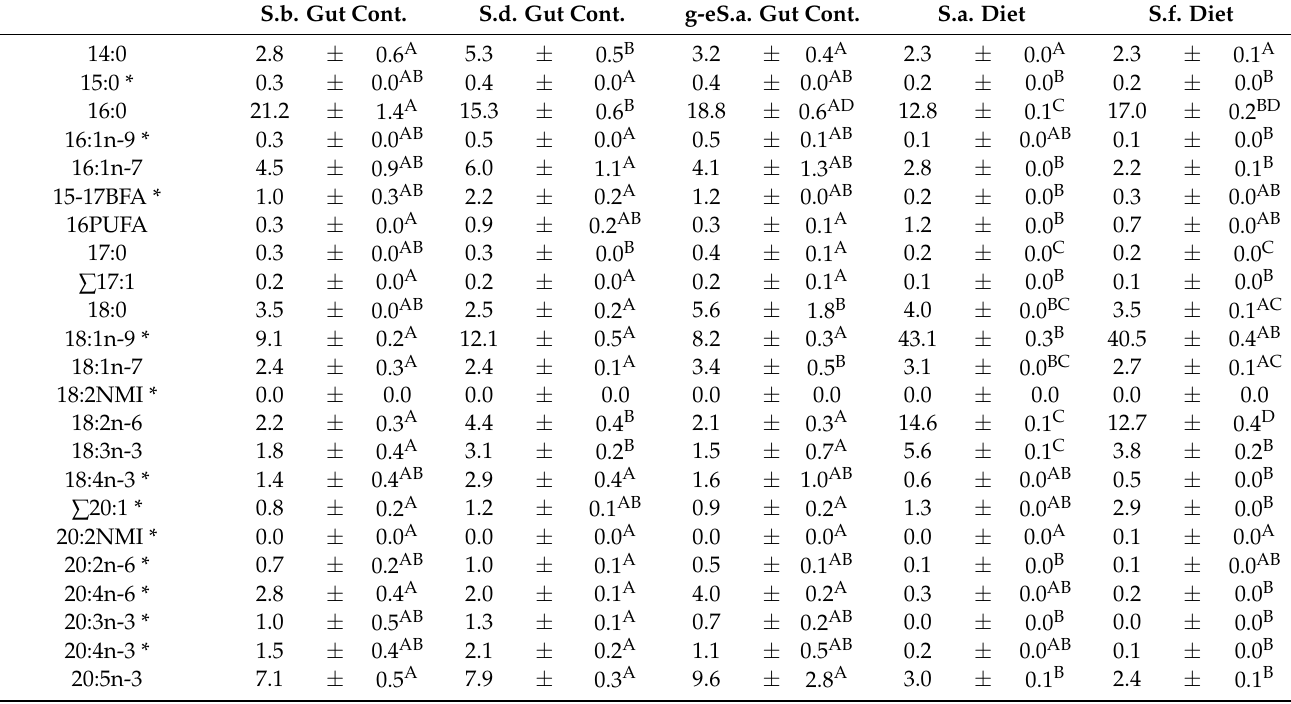
(Table 4). Total content of fatty acids, mg per g of dry weight, tended to be the highest in diet of S. alpinus and the lowest in gut contents of S. boganidae (Table 4). Sum EPA+DHA content tended to be the highest in food of S. drjagini (Figure 5). Table 4. Mean values of percentages (% of total fatty acids ± standard error) and total contents ( ∑ FA, mg · g − 1 dry weight) of fatty acids in food of studied fish: gut content of boganid charr Salvelinus boganidae ( S.b . gut cont., number of samples, n = 2); Dryagin’s char Salvelinus drjagini ( S.d . gut cont., n = 5); goggle-eyed charr (the form of Salvelinus alpinus complex) (g-e S.a . gut cont., n = 2); all from Lake Sobachye, diet of Arctic charr Salvelinus alpinus from the Ropsha farm ( S.a . diet, n = 5); diet of brook trout Salvelinus fontinalis from the aquaculture of Timiryazev Academy ( S.f. diet, n = 5). Normally distributed variables are compared by ANOVA and Tukey HSD post hoc test; the other variables marked with asterisk * and are compared by Kruskal–Wallis test. Means labelled with the same letter are not significantly different at p < 0.05 according to the relevant test. When Kruskal–Wallis test is insignificant, letter labels are